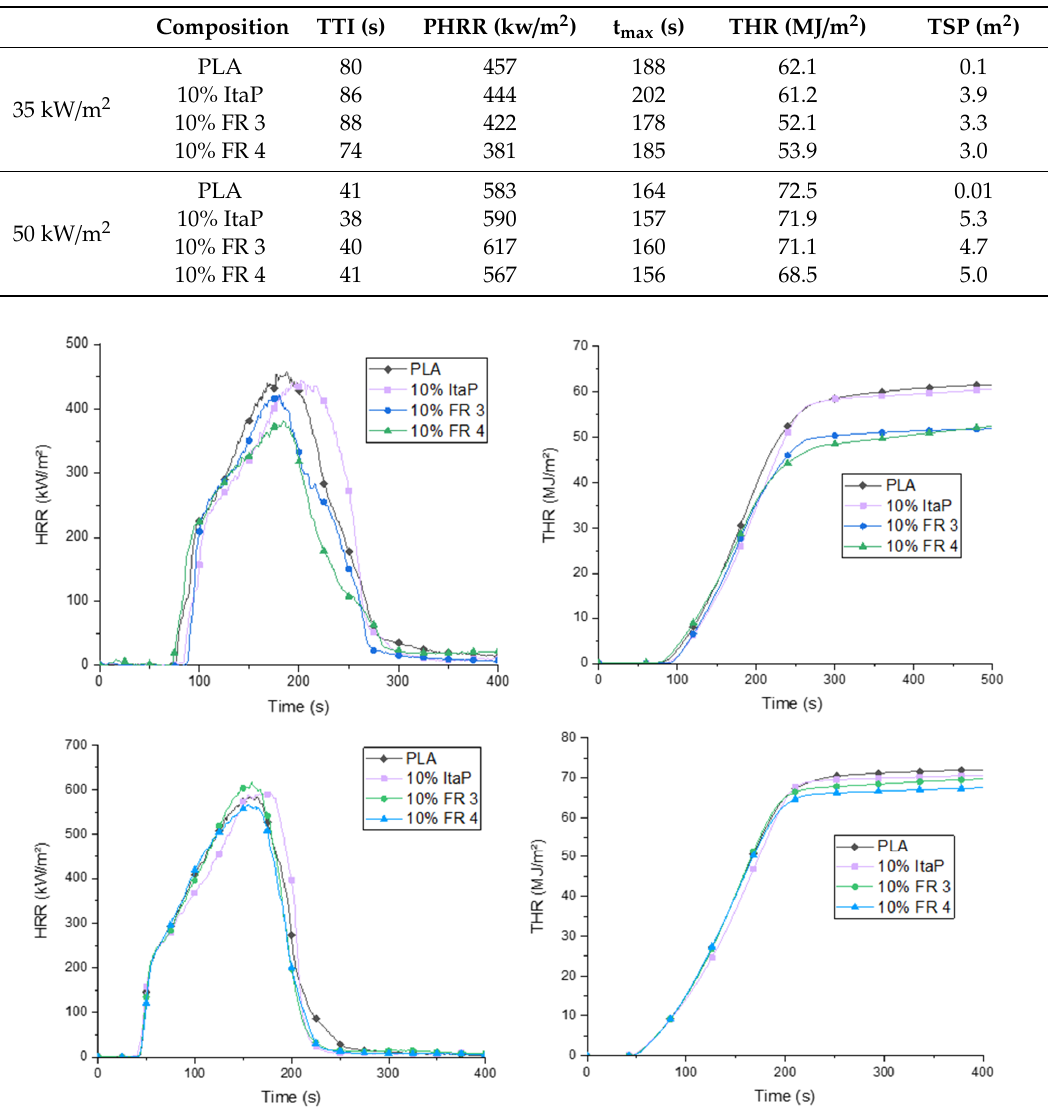
Figure 6. Heat release rate (HRR) (left) and total heat release (THR) (right) curves for flame retardant formulations at a heat flux of 35 kW/m² (top) and 50 kW/m² (bottom).